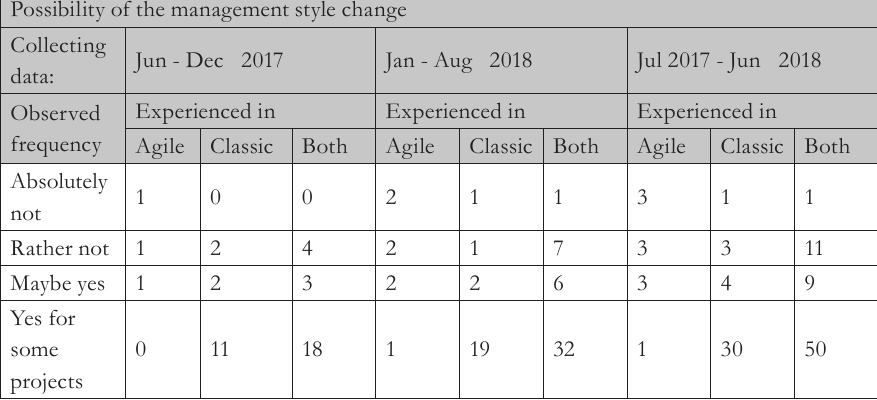
Tab. 3 – Total number of responses collected in the years 2017 and 2018 Source: own research